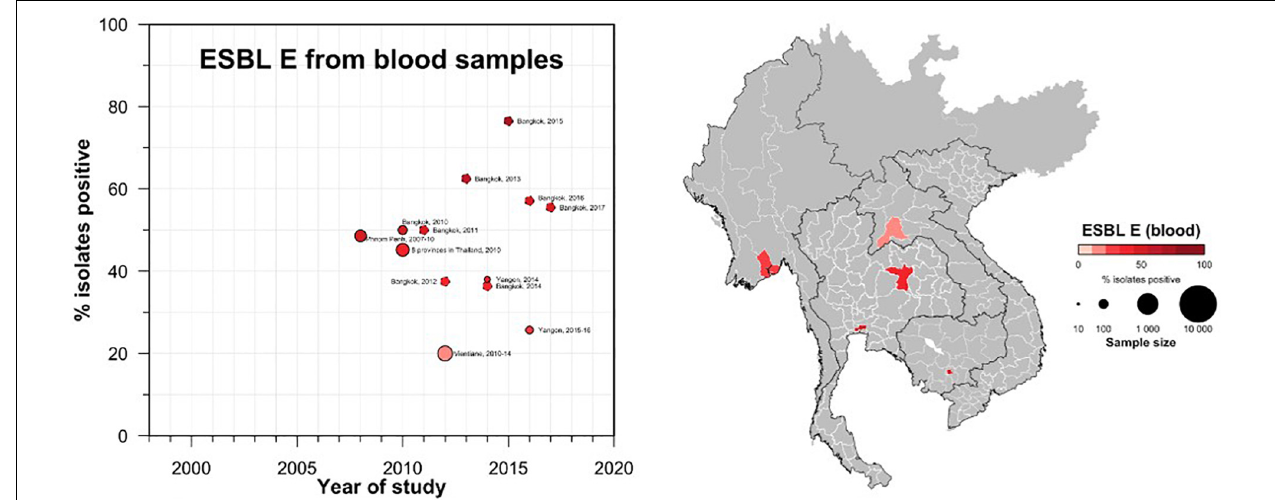
FIGURE 5 | Clinical ESBL-E prevalence proportion in GMS. Observed ESBL prevalences, presented as proportions, of Enterobacterales isolated from clinical—blood specimens in the Greater Mekong Subregion over time and across geographical regions. The smallest unit of geographical regions considered, demarcated by white lines on the map, is the first-order administrative units or provinces. The size of the points corresponds to the sample size of the studies, and broken rings represent studies that do not report a sample size. Darker points and regions indicate a higher prevalence of ESBL E, and province with no observed data are shaded gray. If multiple studies were available for a province, the highest value is presented. For studies across multiple provinces, the ESBL E overall prevalences are presented for all the named provinces.